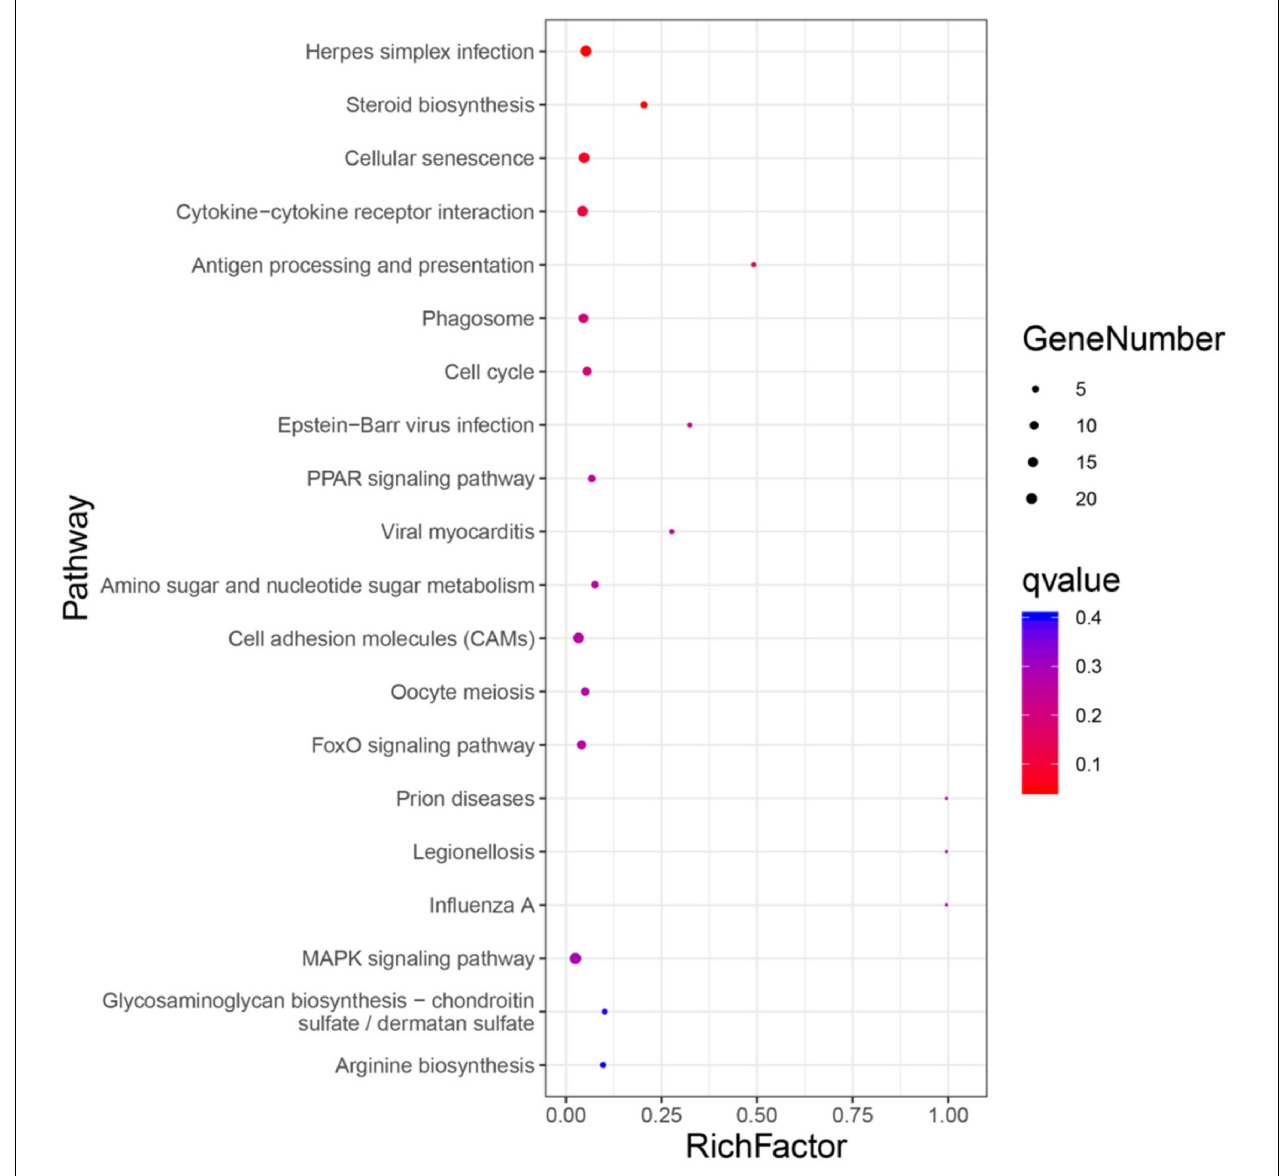
FIGURE 3 | Top 20 pathway enrichments. The x -axis indicates the ratio of the number of genes in the pathway of the DEGs and all genes. The y -axis indicates the pathway.